Question: Condense the content of this figure into a single sentence.
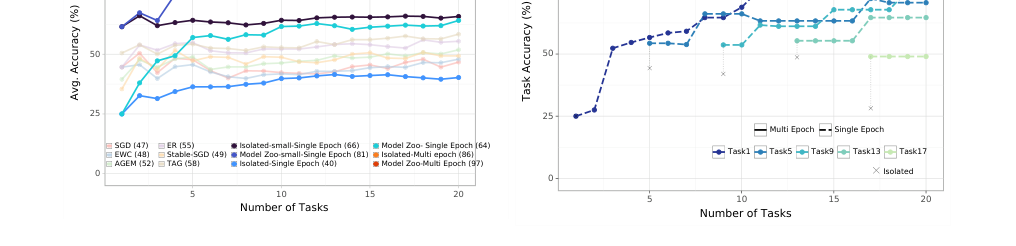
Answer: Left: How well do existing continual learning methods work in the single-epoch setting? We track the average accuracy (over all tasks seen until the current episode) on the Split-miniImagenet dataset. All methods in this plot (unless speciﬁed otherwise) are evaluated in the single-epoch setting (Lopez-Paz and Ranzato, 2017), i.e., each new task is allowed only 1 epoch of training. We compare our method Model Zoo and its variants (all in bold) to existing continual learning methods designed for the single-epoch setting (faint lines, see Table 1 for references). Isolated refers to a very simplistic realization of Model Zoo where a separate model is ﬁtted at each episode without any continual learning, or data sharing between tasks; Isolated-small or Model Zoo-small refer to using a very small deep network with 0.12M weights. A number of surprising ﬁndings are seen here. (i) Isolated-small (black) outperforms existing methods by more than 10%, while having a faster training time